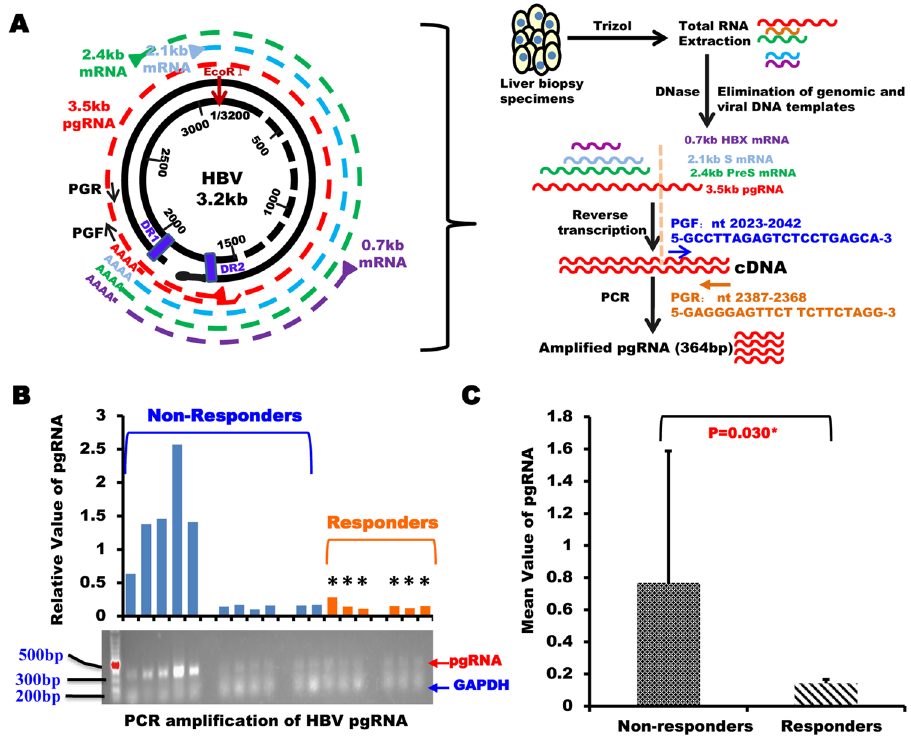
Figure 4. Difference of intrahepatic pgRNA in non-responders versus responders after IFN treatment. ( A ) Flowchart of HBV pgRNA specific amplification procedures. PGF: pgRNA forward primer; PGR: pgRNA reverse primer. ( B ) Agarose gel electrophoresis (lower panel) and quantification (upper panel) of HBV pgRNA products amplified by PCR in liver biopsy after IFN treatment. Note: Patients with HBeAg sero-conversion are marked with “ * ”. ( C ) Mean values of intrahepatic pgRNA in non-responders versus responders after IFN